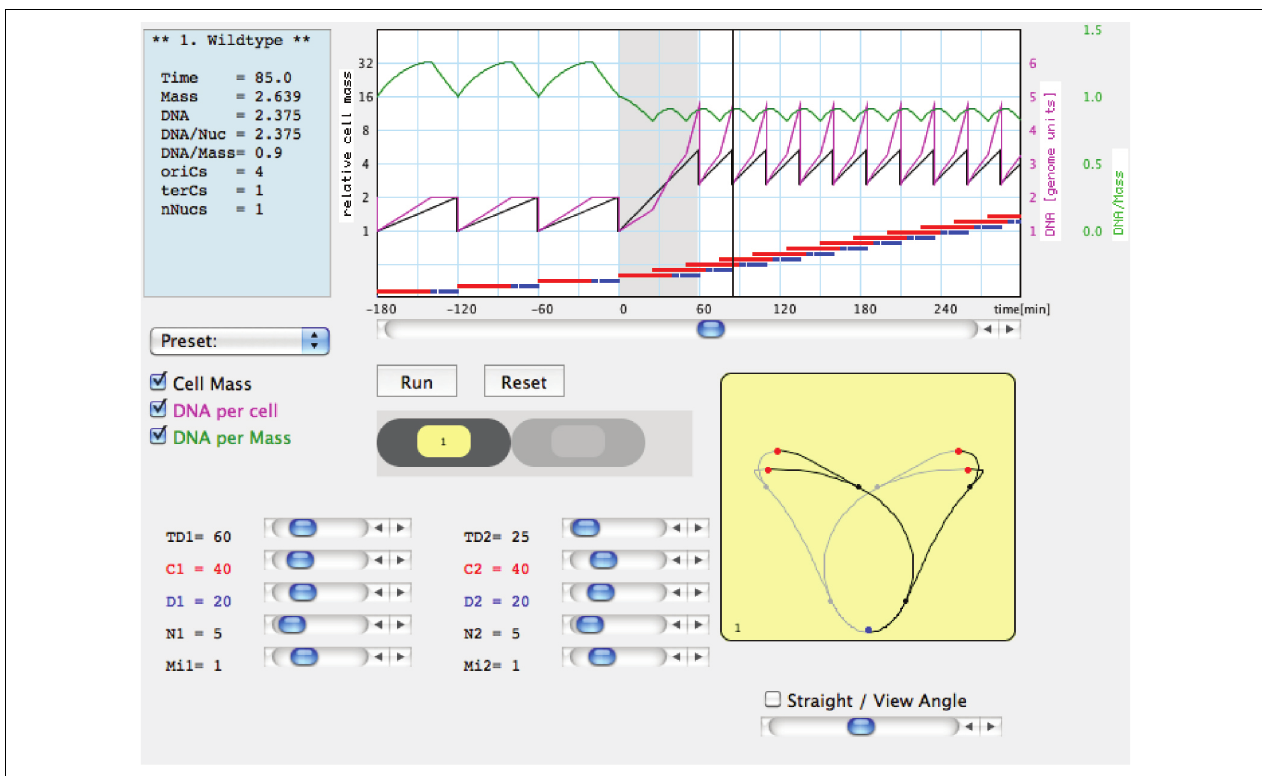
FIGURE 2 | Example of a work window of the Cell Cycle Simulation program (CCSim) for a nutritional shift-up from a doubling time (cid:28) 1 = 60 min to (cid:28) 2 = 25 min. The interactive program can be downloaded from: https://sils.fnwi.uva.nl/bcb/.